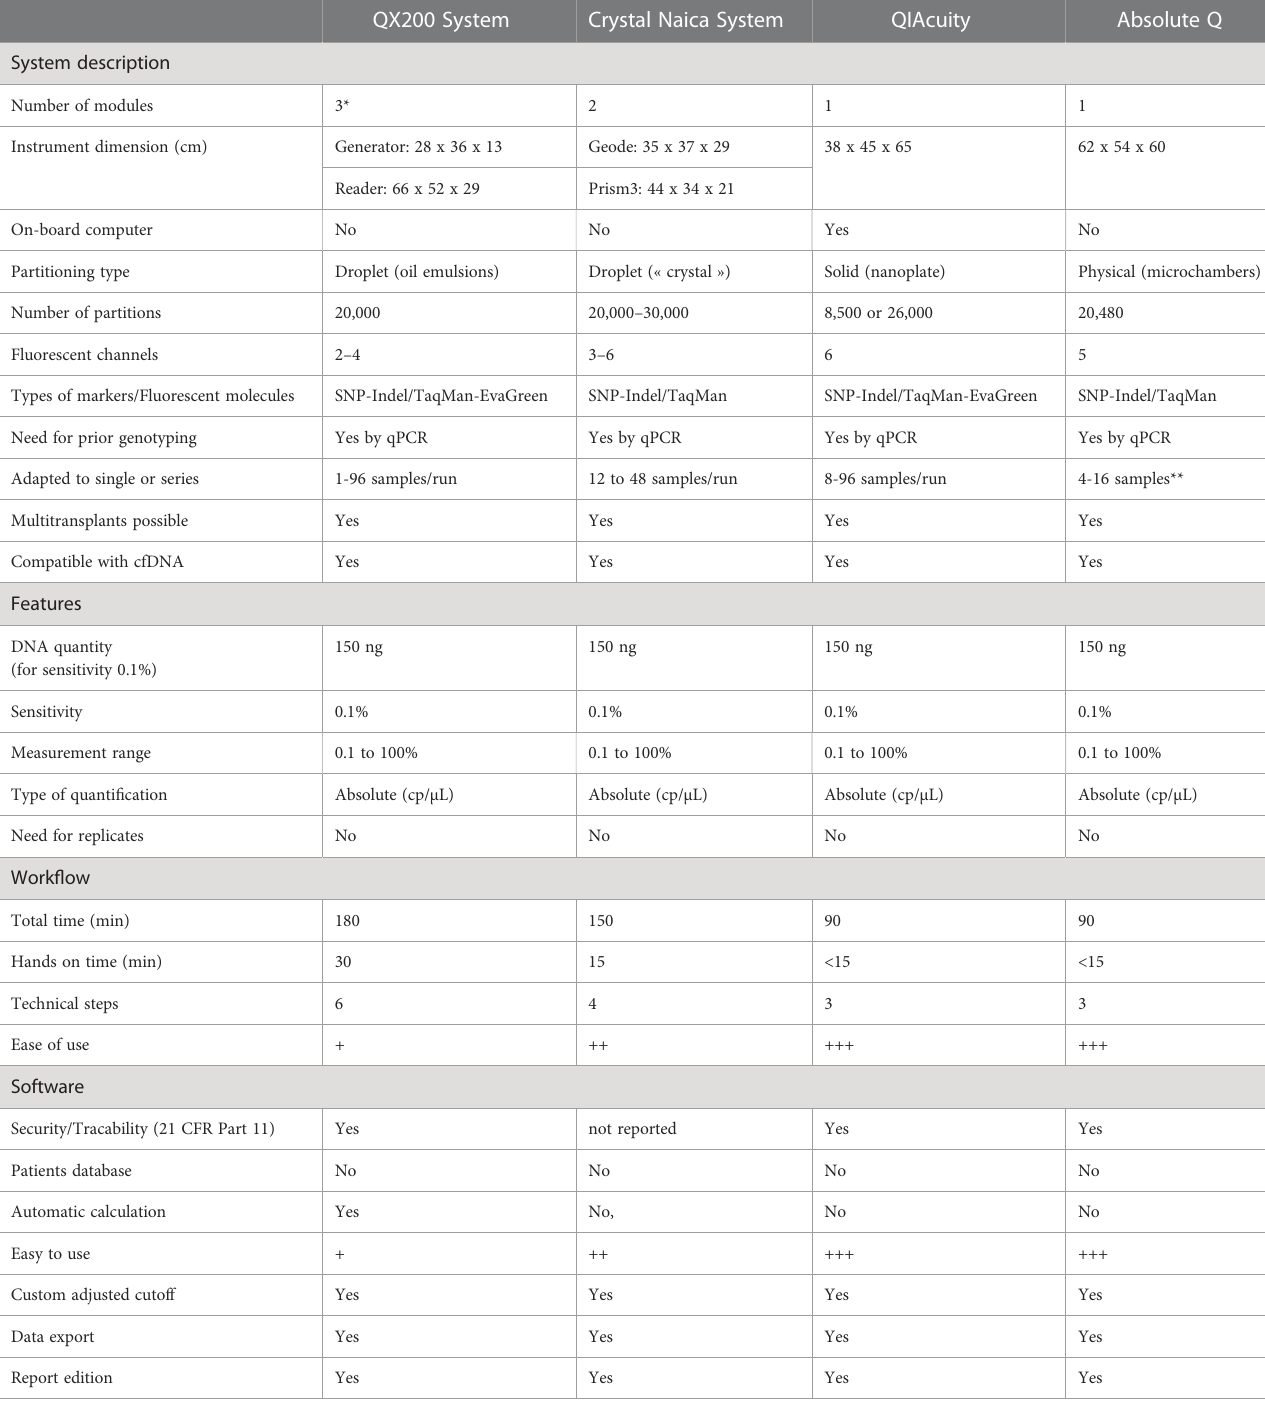
TABLE 2 Comparison of dPCR methods for chimerism analysis. +++: very easy, ++: easy, +: less